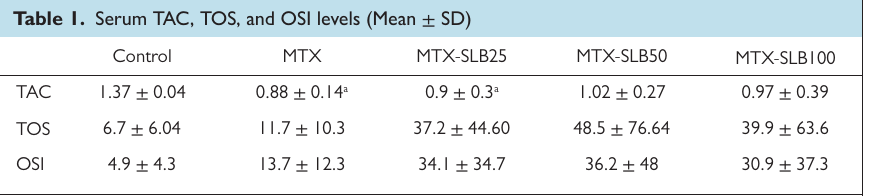
Table 1. Serum TAC, TOS, and OSI levels (Mean ± SD) Control